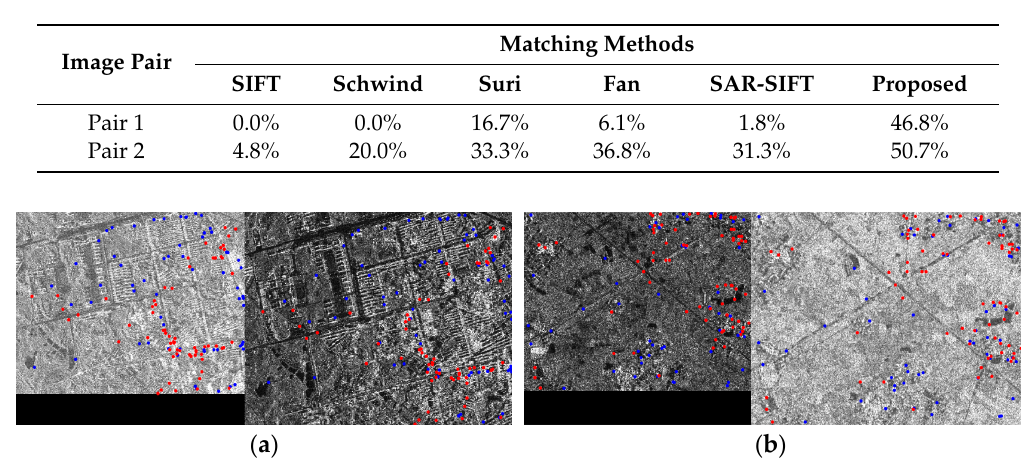
Figure 10. Matching results of the proposed method between SAR and SAR images. In the matching results, correct matches are marked as red points. False matches are marked as blue points. ( a ) Matching results of the proposed method for the first pair of images described in Table 2; ( b ) matching results of the proposed method for the second pair of images described in Table 2.